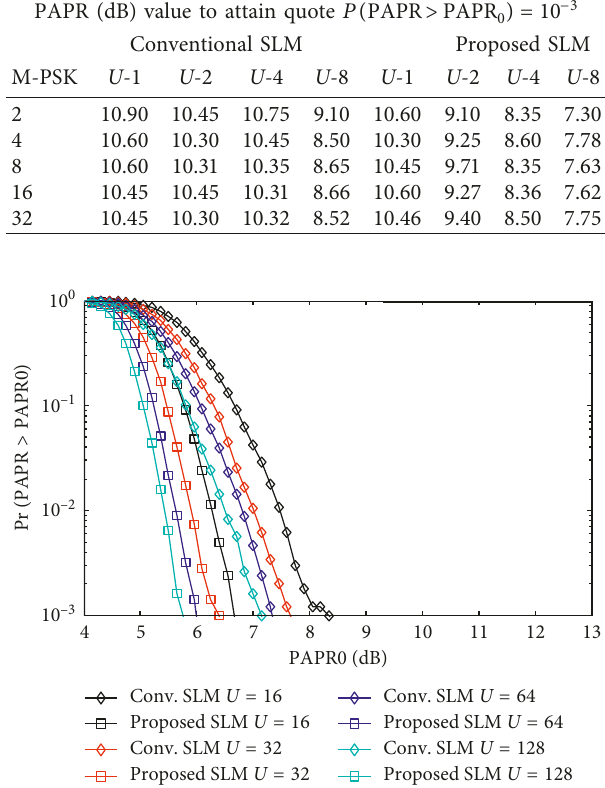
Figure 13: Comparison of SLM given in [5] with the proposed SLM for U � 16, 32, 64, and 128, N � 128, and BPSK.